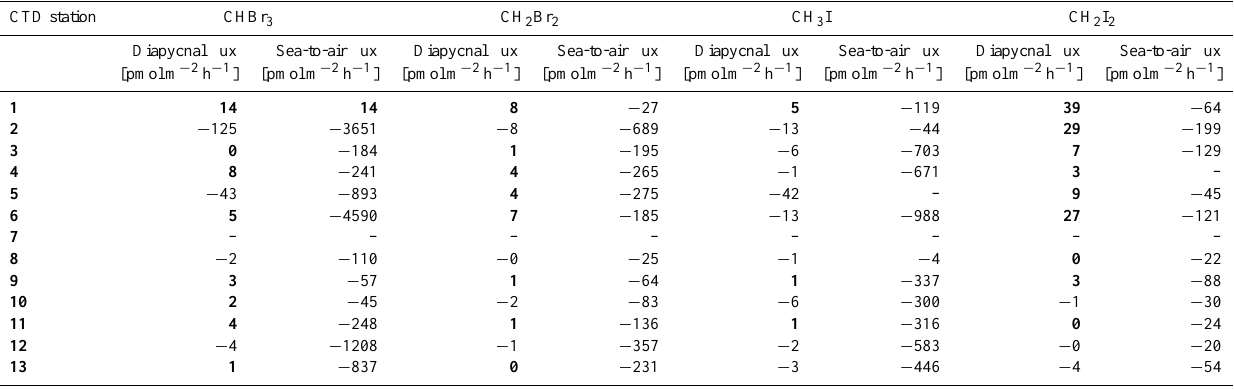
Table 5. Diapycnal and sea-to-air fluxes at every CTD station for the four halocarbons. Positive fluxes in bold provide the mixed layer with the corresponding halocarbon, while negative fluxes indicate losses from the mixed